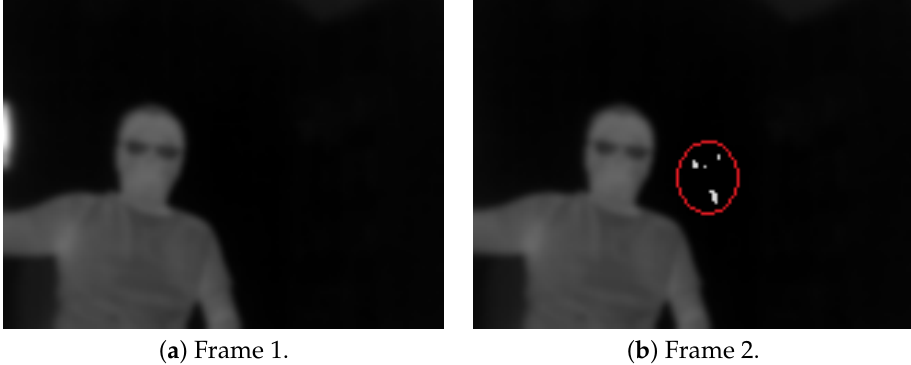
Figure 2. A pair from figure 1 with our technique with small artefacts circled in